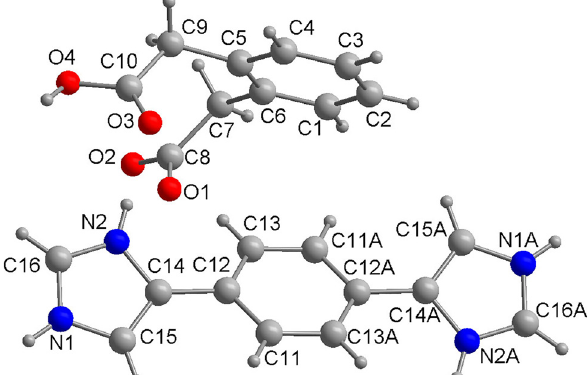
hour at 353 K. The solution was fi ltered, and the fi ltrate was kept at the room temperature. After two weeks, colorless crystals of the title salt were obtained with a yield of 50%.